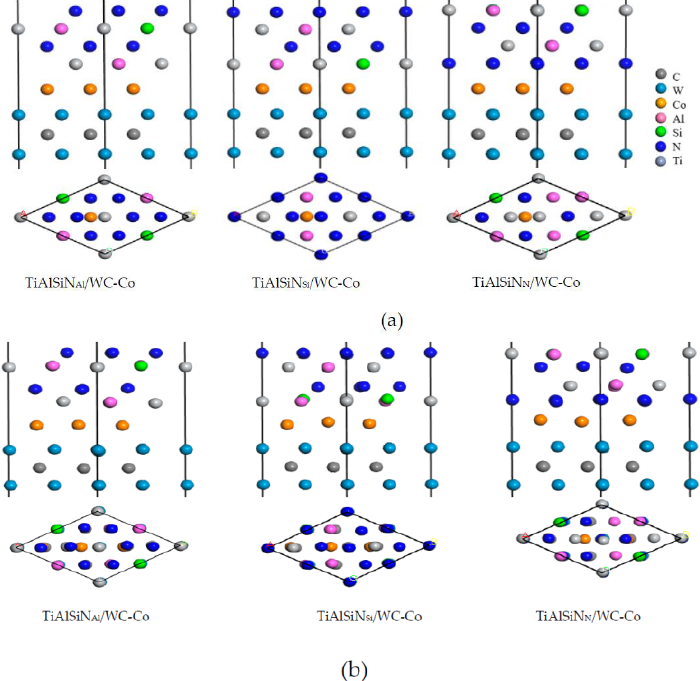
Figure 3. TiAlSiN/WC-Co interface models: ( a ) TiAlSiN/WC-Co interface model before optimization and ( b ) geometrically optimized TiAlSiN/WC-Co interface model.